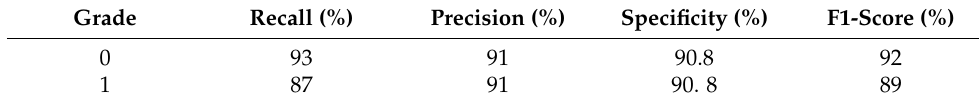
Table 7. Results of our proposed DHL-II applied on the unseen dataset of two classes. Grade